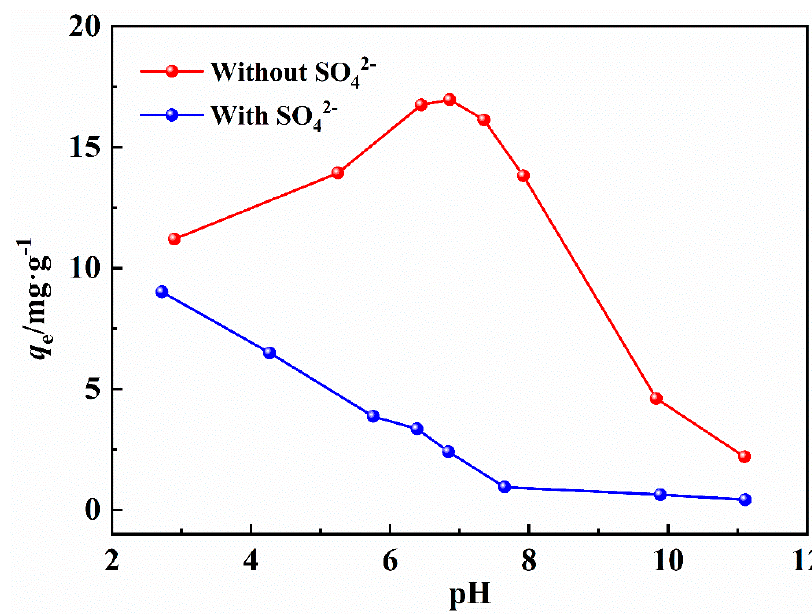
Figure 6. Effect of pH on phosphate removal by HTO